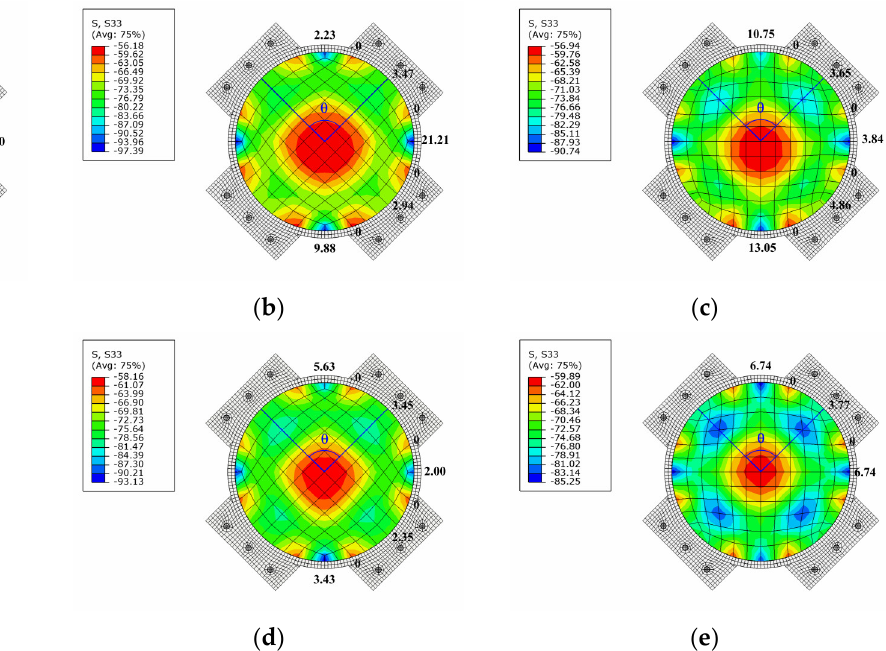
Figure 25. Distribution of S33 of core concrete and p at peak strength (in MPa): ( a ) θ = 0 ◦ ; ( b ) θ = 90 ◦ ; ( c ) θ = 180 ◦ ; ( d ) θ = 270 ◦ ; ( e ) θ = 360 ◦ . Spherical-cap gap ratio χ of 2.3%, 4.6%, 6.9% and 9.2% are selected in the FEA analysis. The N - ∆ curves of BWCFST short columns with spherical-cap gap are shown in Figure 26. The peak strengths of BWCFST columns are 5714 kN, 5397 kN, 5258 kN and 5144 kN with χ of 2.3%, 4.6%, 6.9% and 9.2%, respectively, and the corresponding SI are 0.9798, 0.9254, 0.9016 and 0.8820. Compared with the experiment, the spherical-cap gap shows a smaller degree of weakening to the peak strength of the specimen.